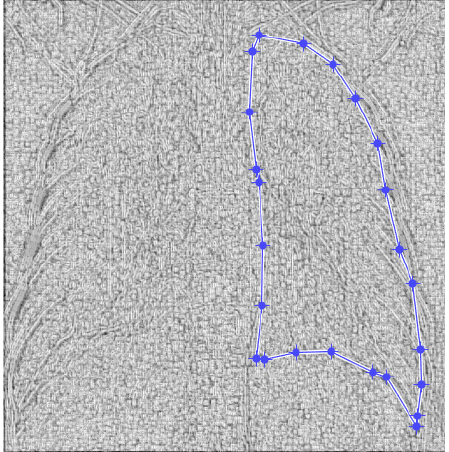
Figure 15. De fi ning the mask for the right lung of the third patient.